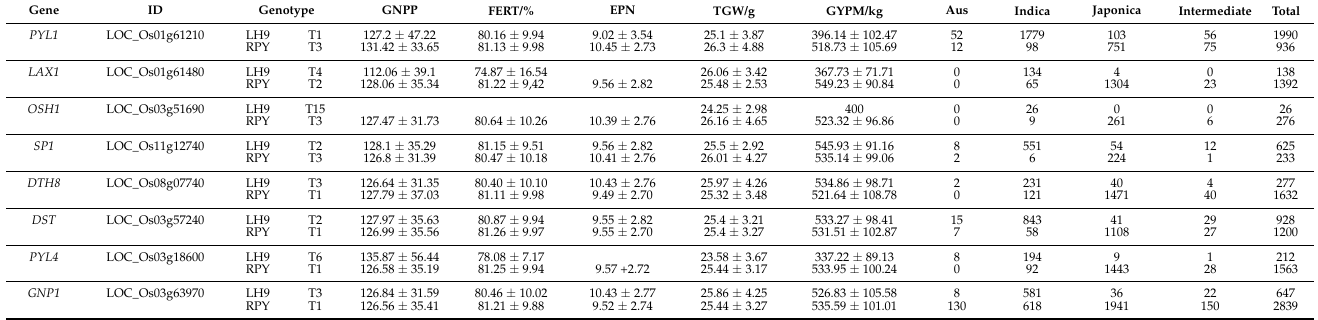
Table 3. Parental genotypes in the MBK database corresponding to genotypes and yield